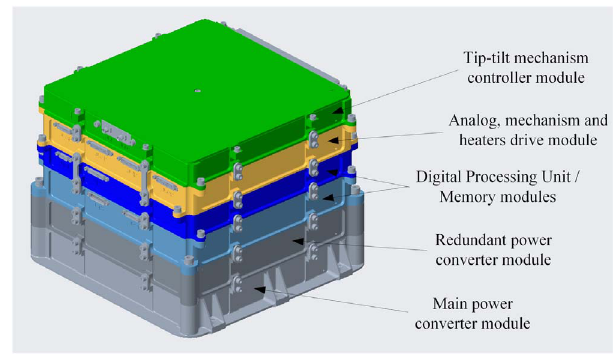
Fig. 7. Preliminary con fi guration of the